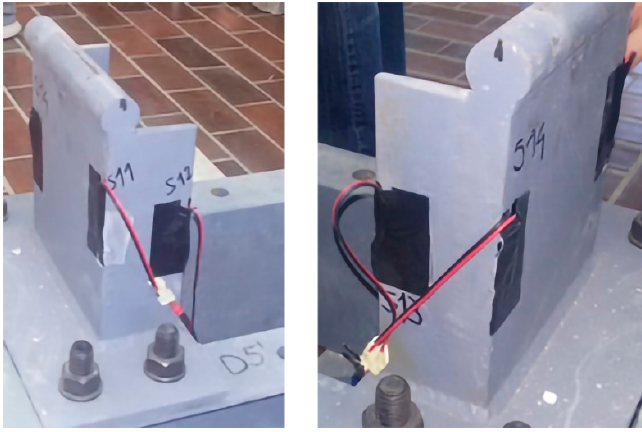
Figure 28. “U” profile at the point of support of the tested specimens on the steel frame.